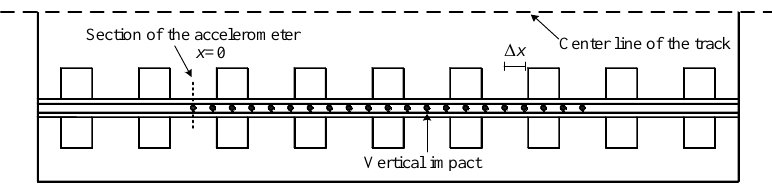
Figure 9. The accelerometer and the hammer impact positions.